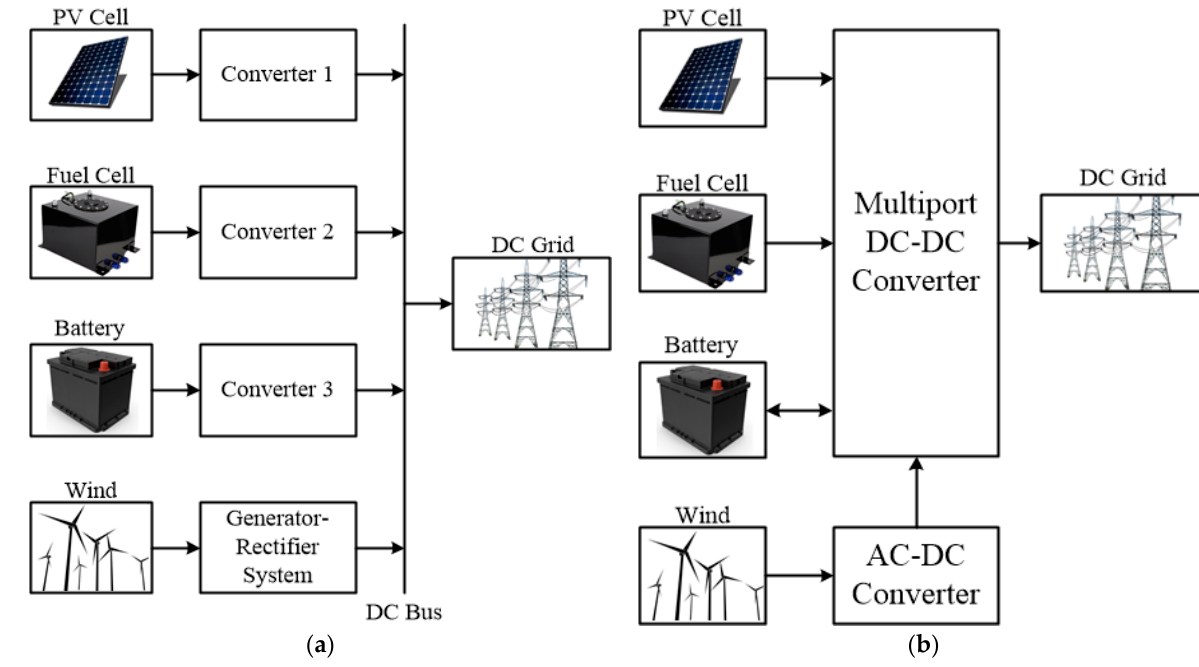
Figure 1. Block diagram of ( a ) conventional multi input multiple converter system and ( b ) multiport converter.